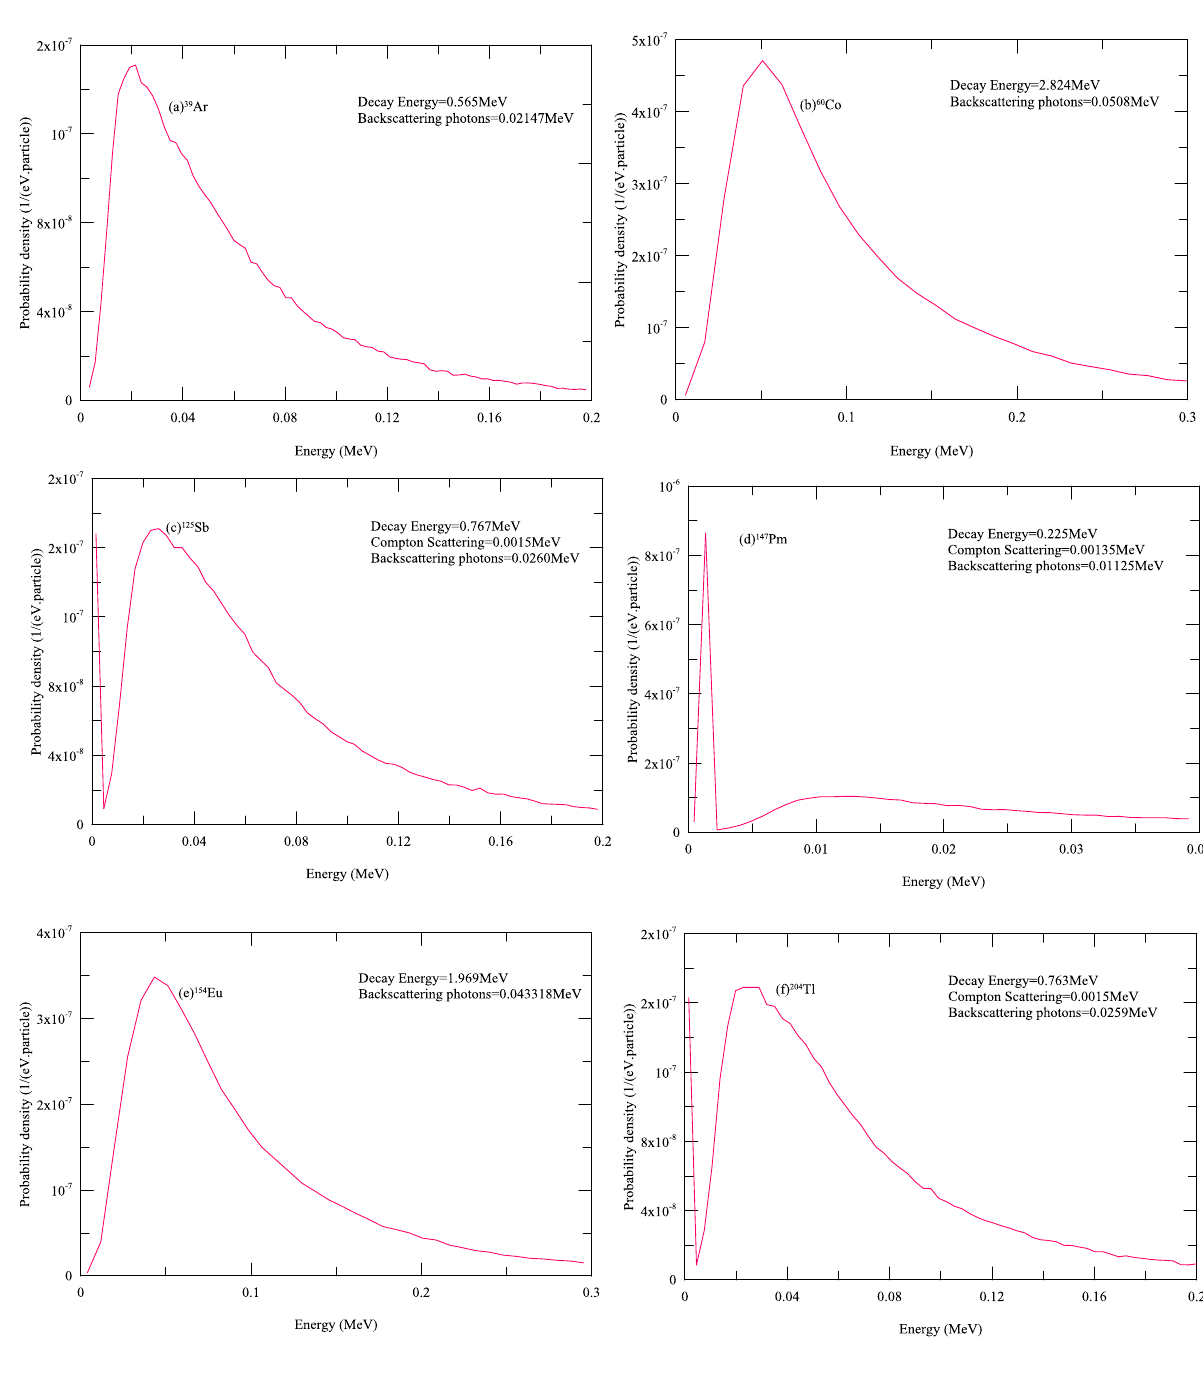
Fig.8: The backscattered of bremsstrahlung photons produced by absorption of (a) 39 Ar, (b) 60 Co, (c) 125 Sb, (d) 147 Pm, (e) 154 Eu, and (f) 204 Tl beta particles into silicon